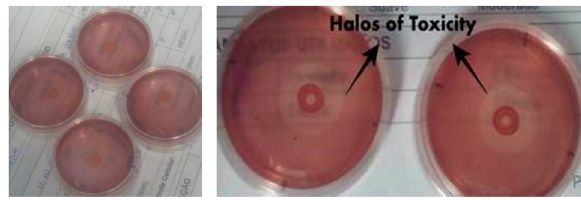
Figure 4: In vitro cytotoxicity testing results. Samples of negative control ( fi lter paper ) are marked *. Samples of the membrane are marked + . The tin samples did not show halos of toxicity. The samples from the positive control group ( latex ) showed halos of toxicity.